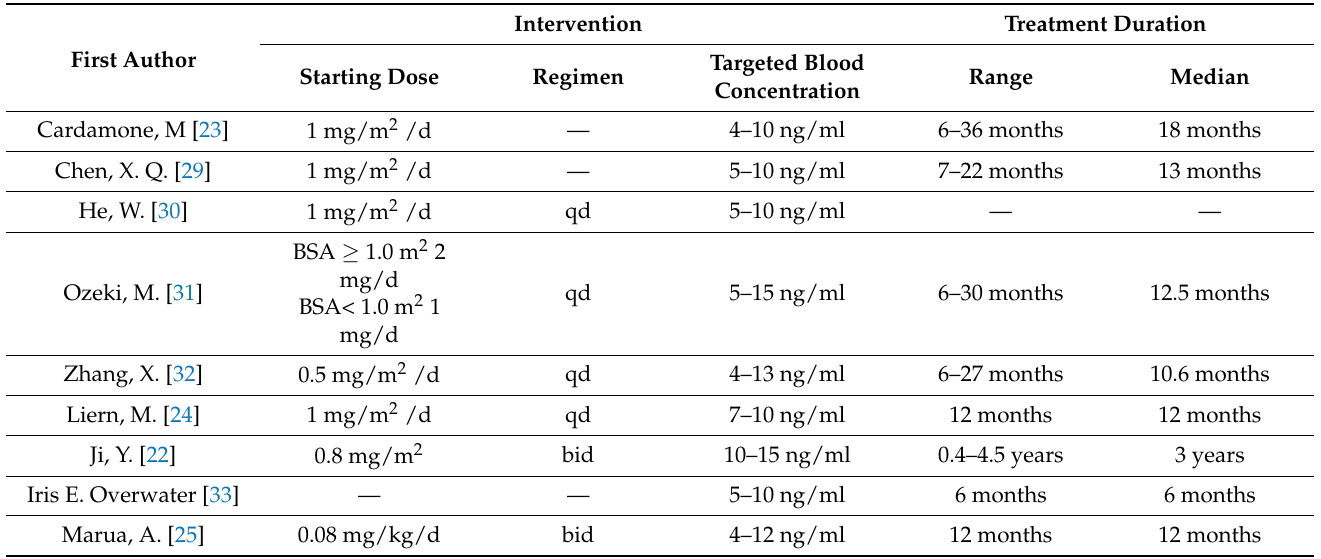
Table 2. List of studies identified and selected through database searches: intervention.